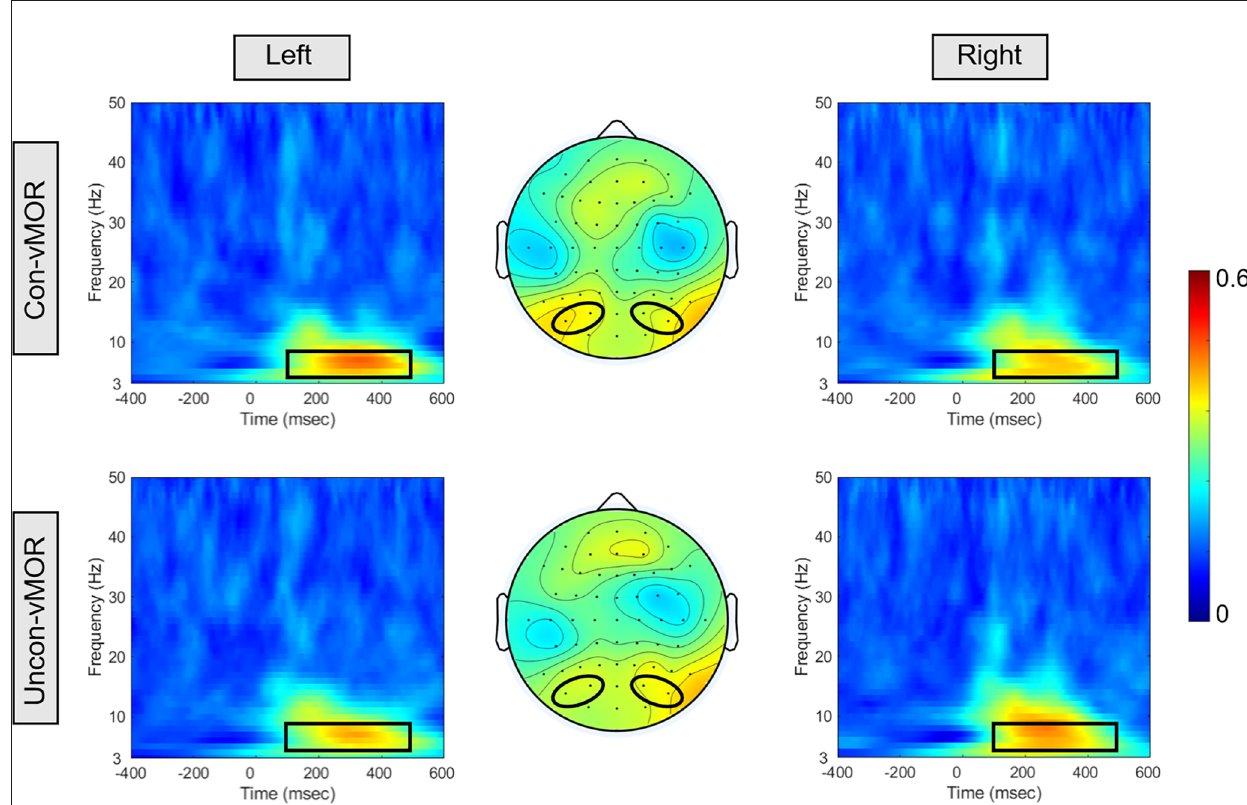
FIGURE4 ITPCs and their isocontour map for each condition. The panels show the ITPCs in the Con-vMOR condition in the left area (PO3, PO7; upper left panel), the Con-vMOR condition in the right area (PO4, PO8; upper right panel), the Uncon-vMOR condition in the left area (lower left panel), the Uncon-vMOR condition in the right area (lower right panel), and their isocontour maps (the upper map is in the Con-vMOR condition, and the lower map is in the Uncon-vMOR condition). The black box in the ITPCs indicates a time-frequency window of 100–500 ms and 4–8